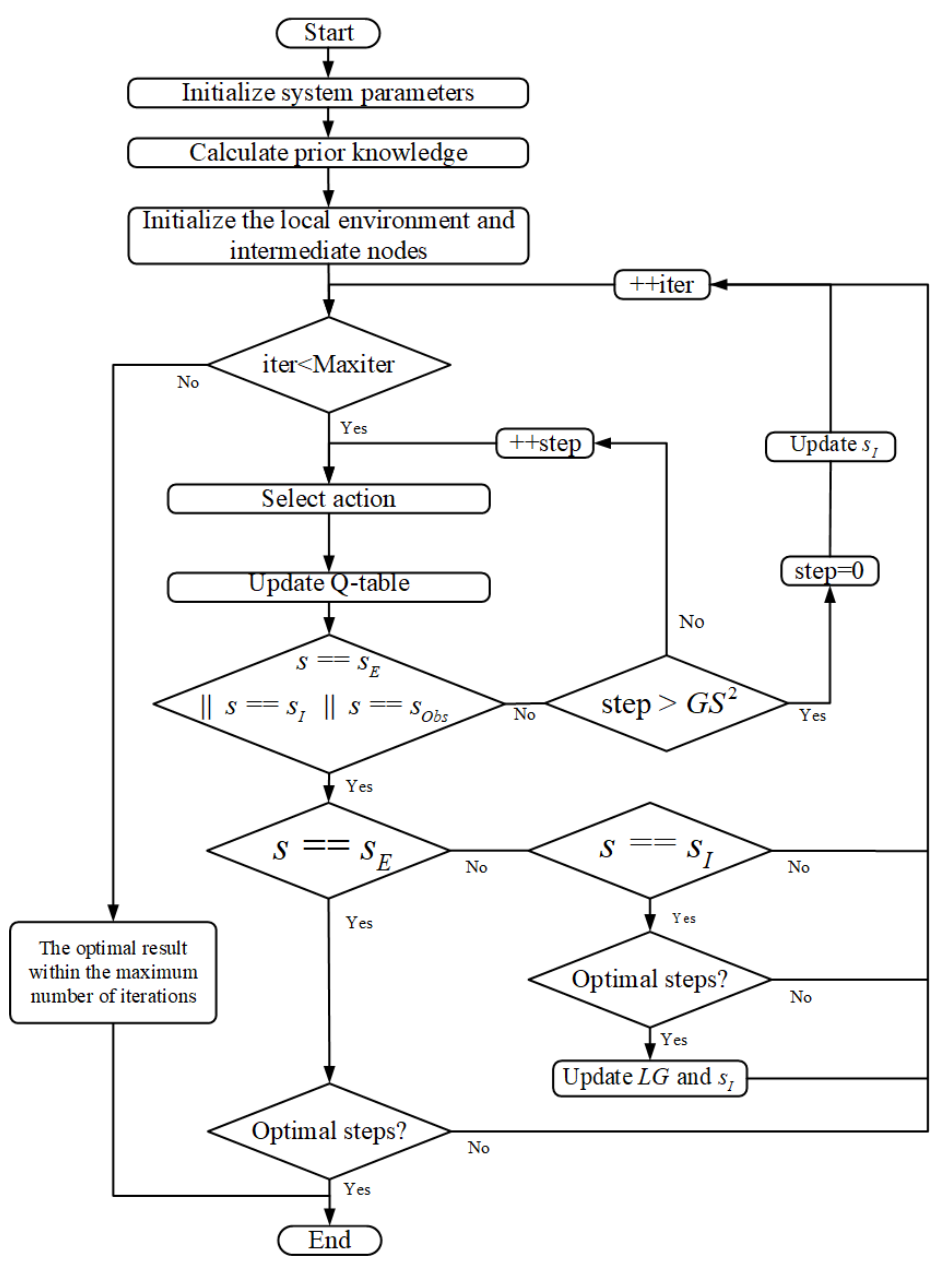
Figure 5. The flow of the CLSQL